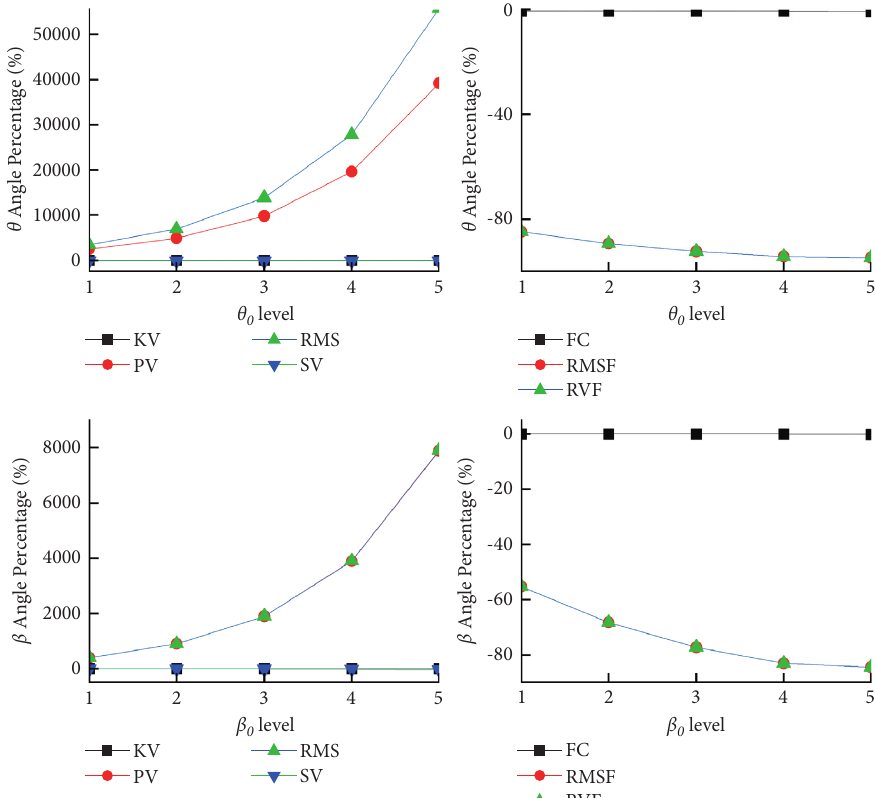
Figure 11: Effect of the initial angles on the lift-luffing